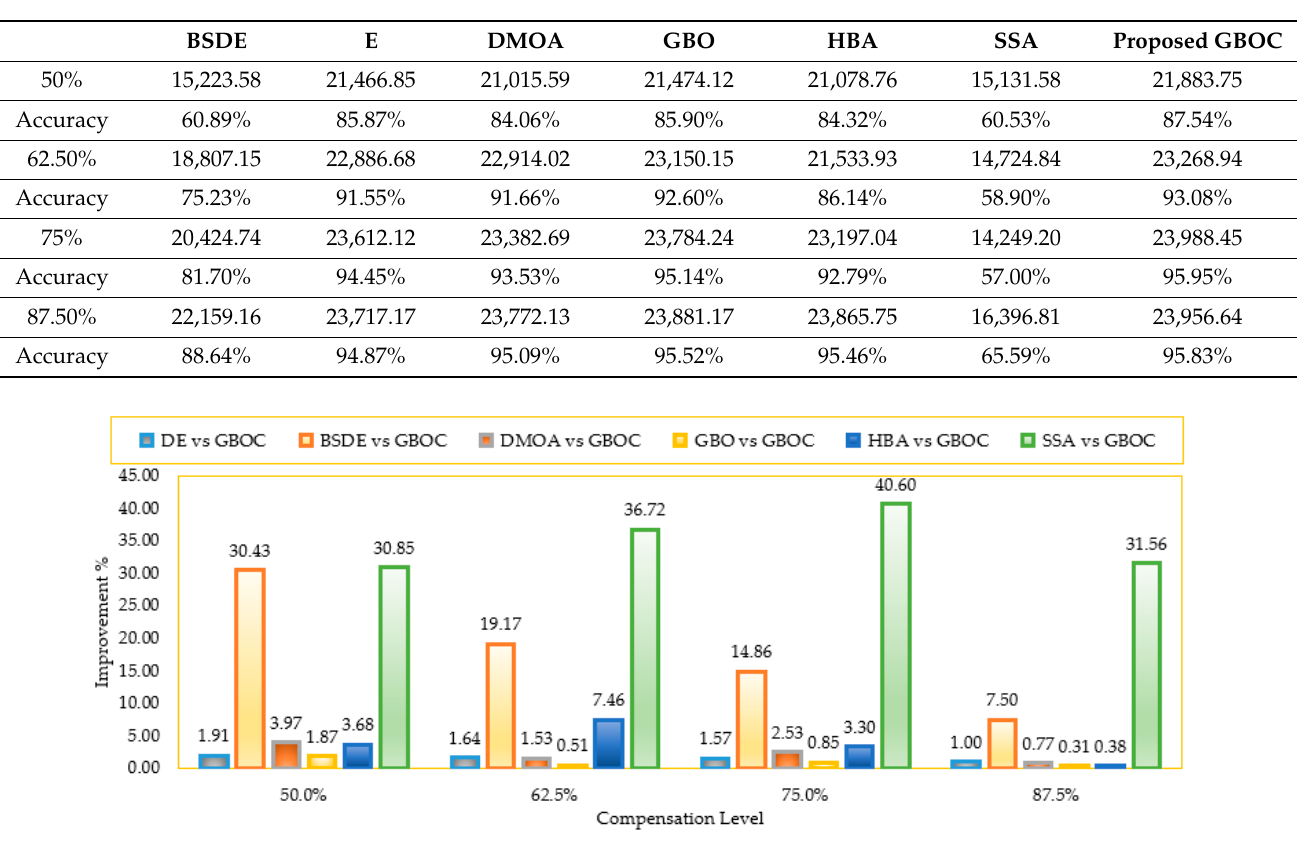
Figure 10. Improvement percentages of the proposed GBOC versus GBO, SSA, DMOA, DE, and HBA for the IEEE 33-distribution system with improved compensation levels.